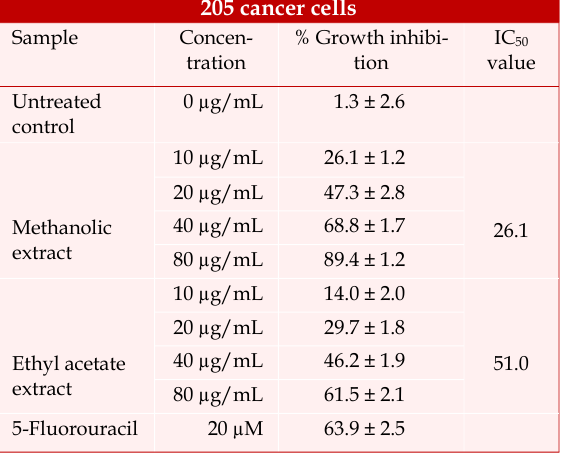
Anti-cancer activity of P. macrophyla against Colo-